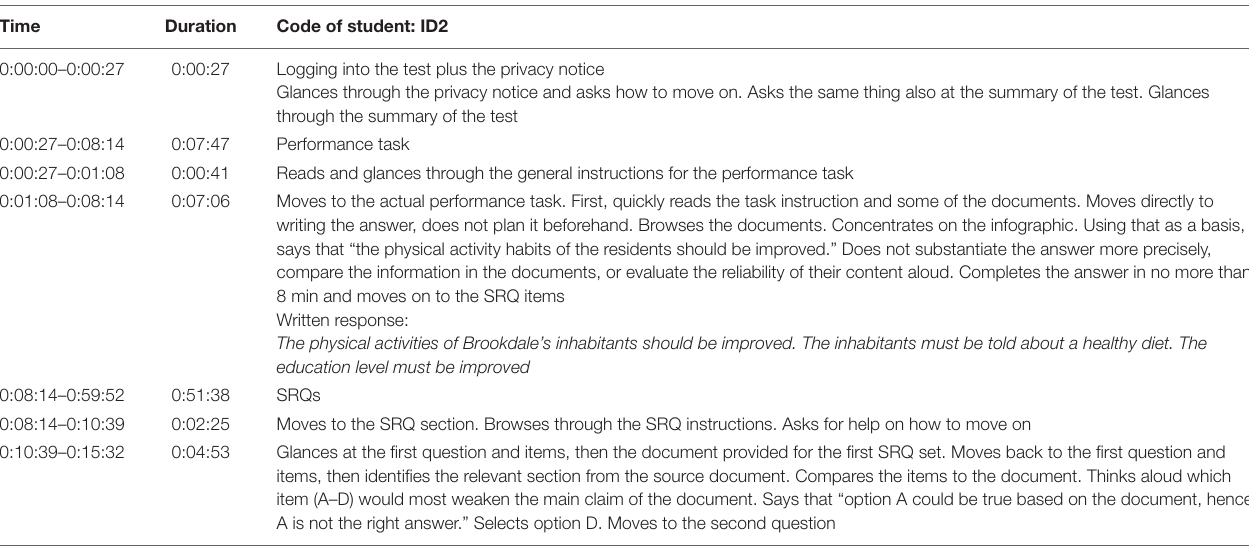
TABLE 2 | An example of a content log (Hyytinen et al.,